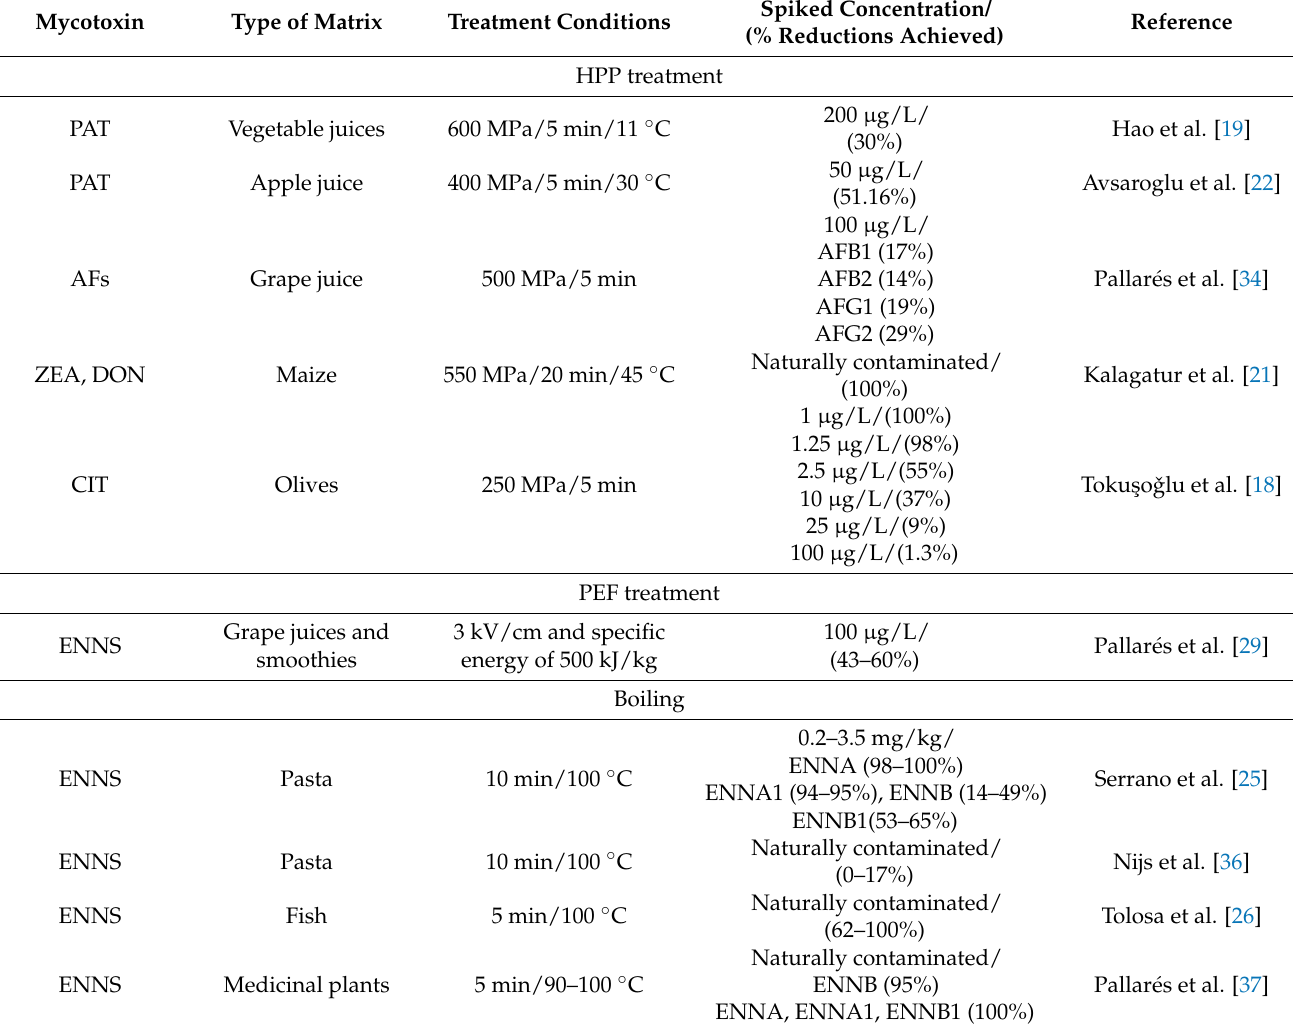
Table 2. Mycotoxin reduction percentages reported in the literature after different types of food